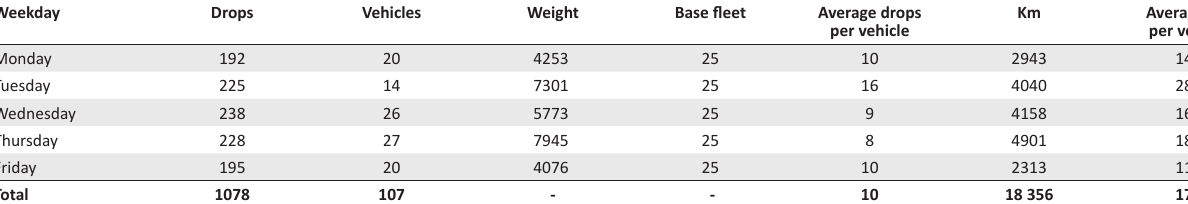
TABLE 3: Distribution centre 3 plan case study baseline.